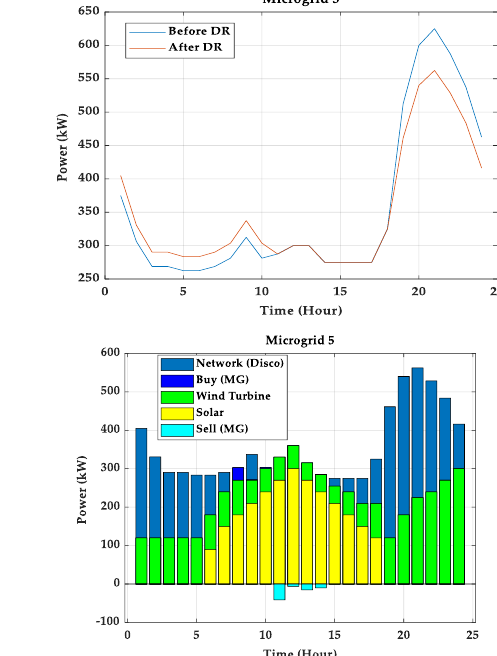
Figure 25. Impact of DR and power-sharing on MGs 4 and 5.